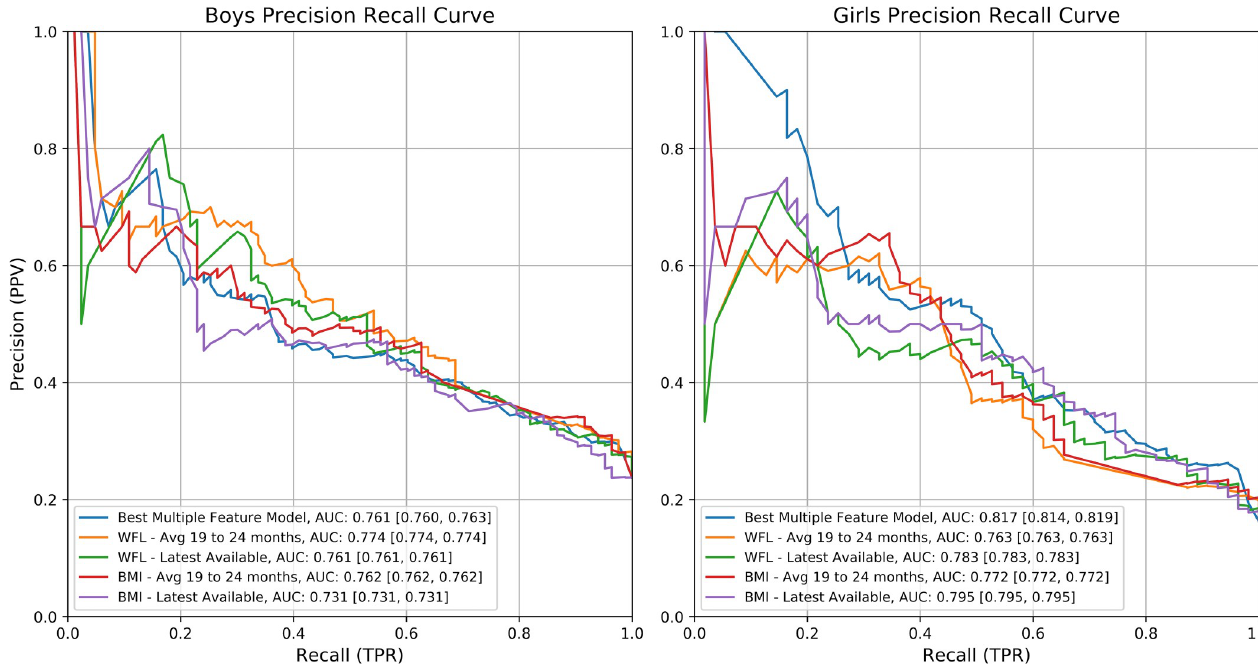
Fig 3. Precision recall curves for the top performing model compared to individual feature